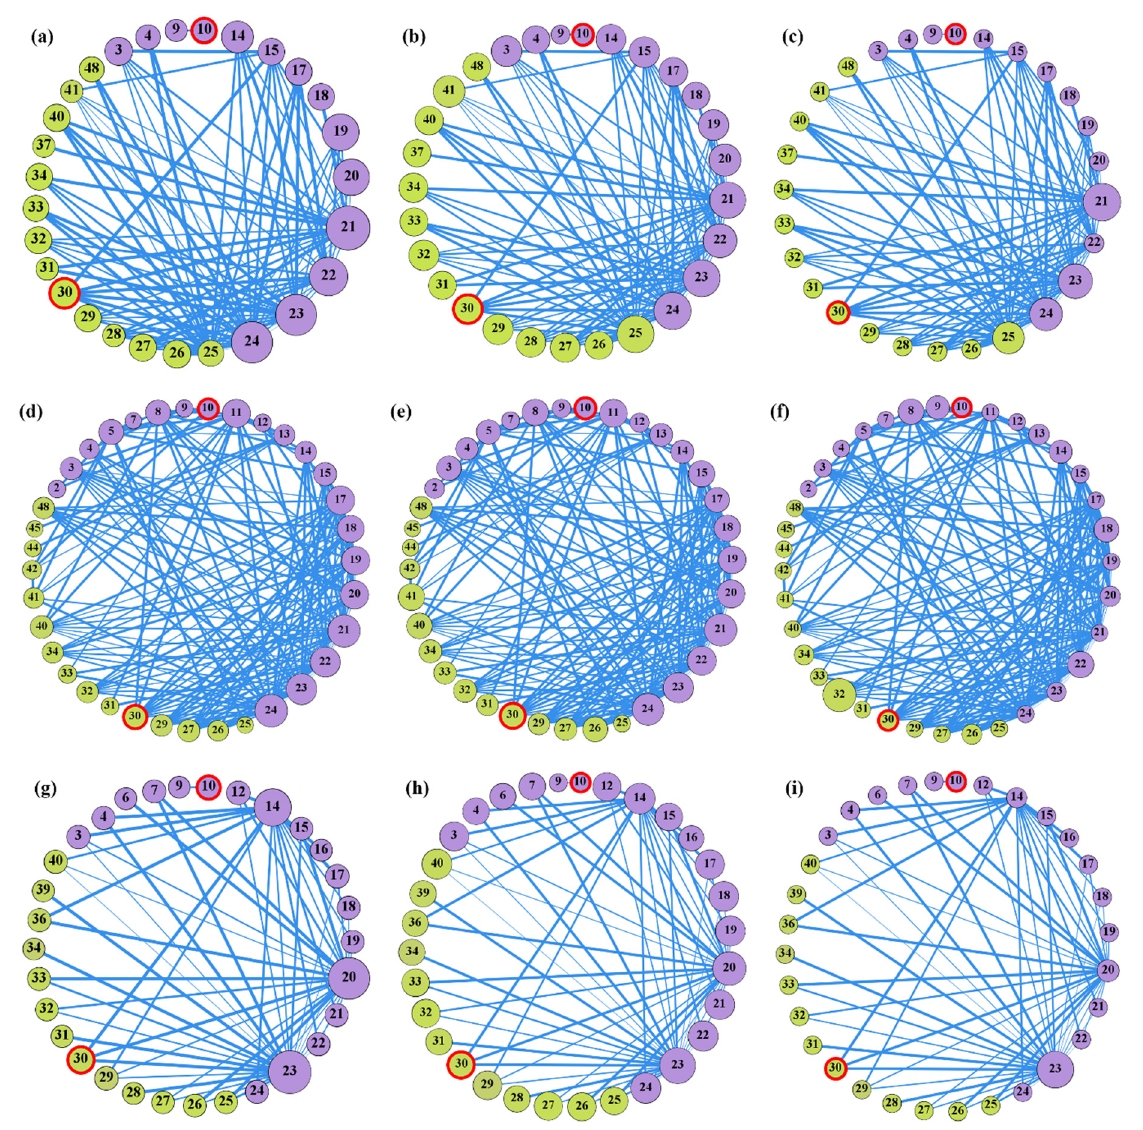
Figure 7. Node centralities of groundwater-centered CB networks. The results for entire cities ( G T ) ( a – c ), coastal cities ( G C ) ( d – f ), and non-coastal cities ( G NC ) ( g – i ). The first column is the results of node strength ( a , d , g ), the second column is closeness centrality ( b , e , h ), and the third column is betweenness centrality ( c , f , i ).